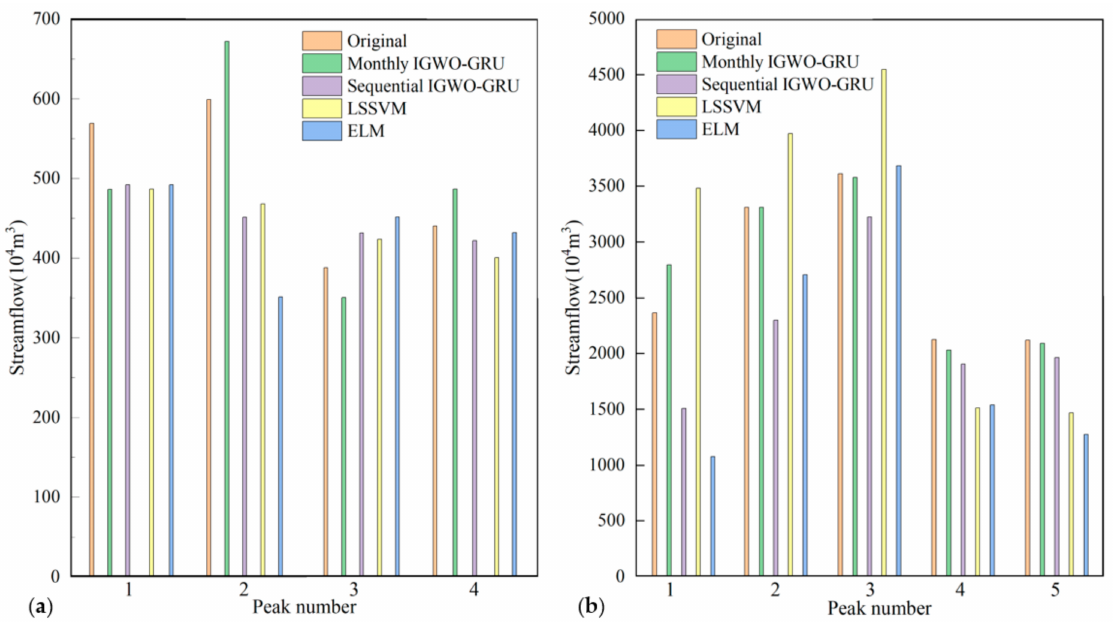
Figure 10. Peak flows of different models for the Shangjingyou station ( a ), and the Fenhe reservoir station ( b ) during the validation